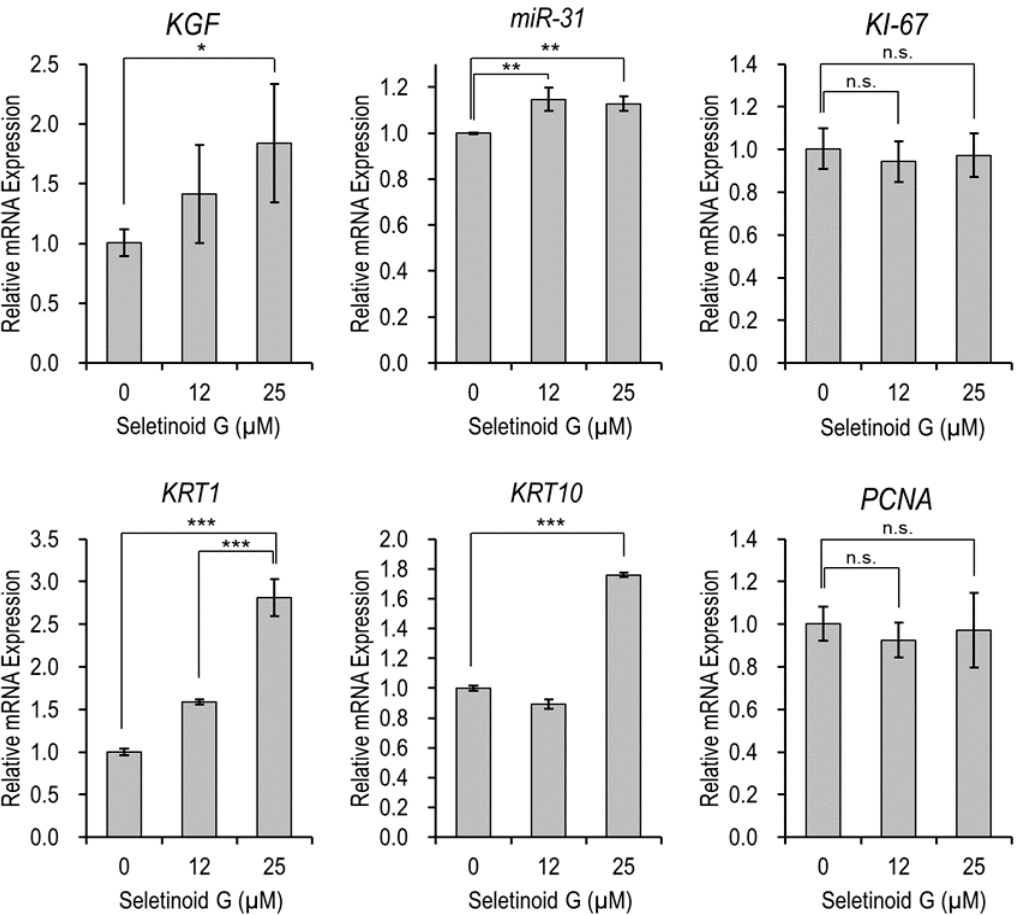
Figure 4. mRNA expression levels of proliferation- and migration-related genes in seletinoid G-treated HaCaT cells. The ribosomal protein lateral stalk subunit P0 ( RPLP0 ) gene was used as an internal control for quantitative real-time PCR. (n.s.: not significant; * p < 0.05; ** p < 0.01; *** p < 0.001).